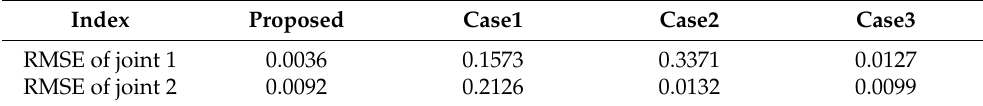
Table 1. RMSE of position-tracking errors with different control